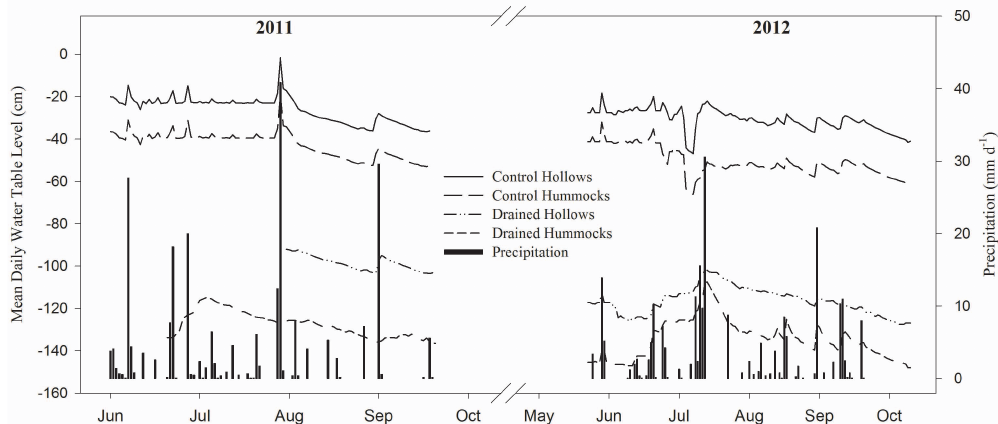
Fig. 2. Water table levels (lines) and daily precipitation (bars) during growing seasons of 2011 and 2012. The cumulative seasonal precipita- tion during 2012 was 30% less than that of 2011.